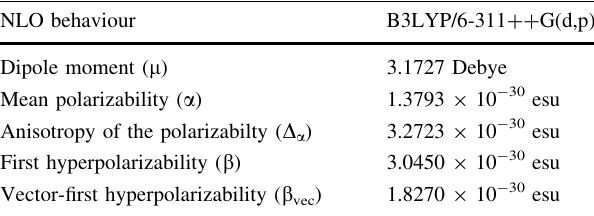
Fig. 13 Mulliken plot of curcumin Table 9 Nonlinear optical properties of curcumin at B3LYP/6- 311 ?? G(d,p) methods and basis set